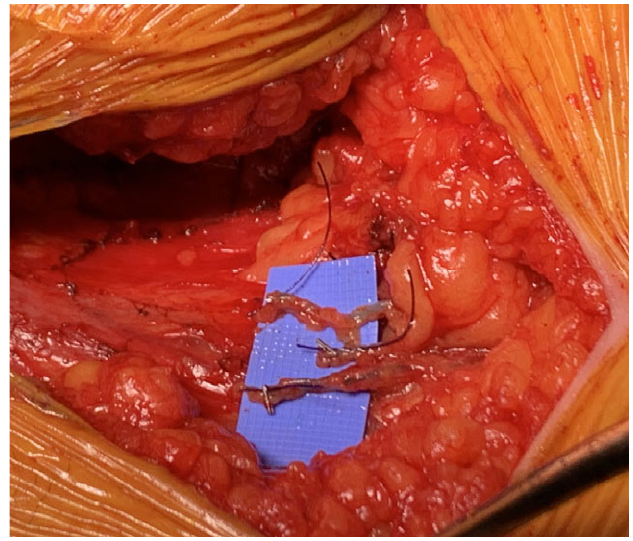
Figure 2. Suture/clip technique to identify lymphatics.